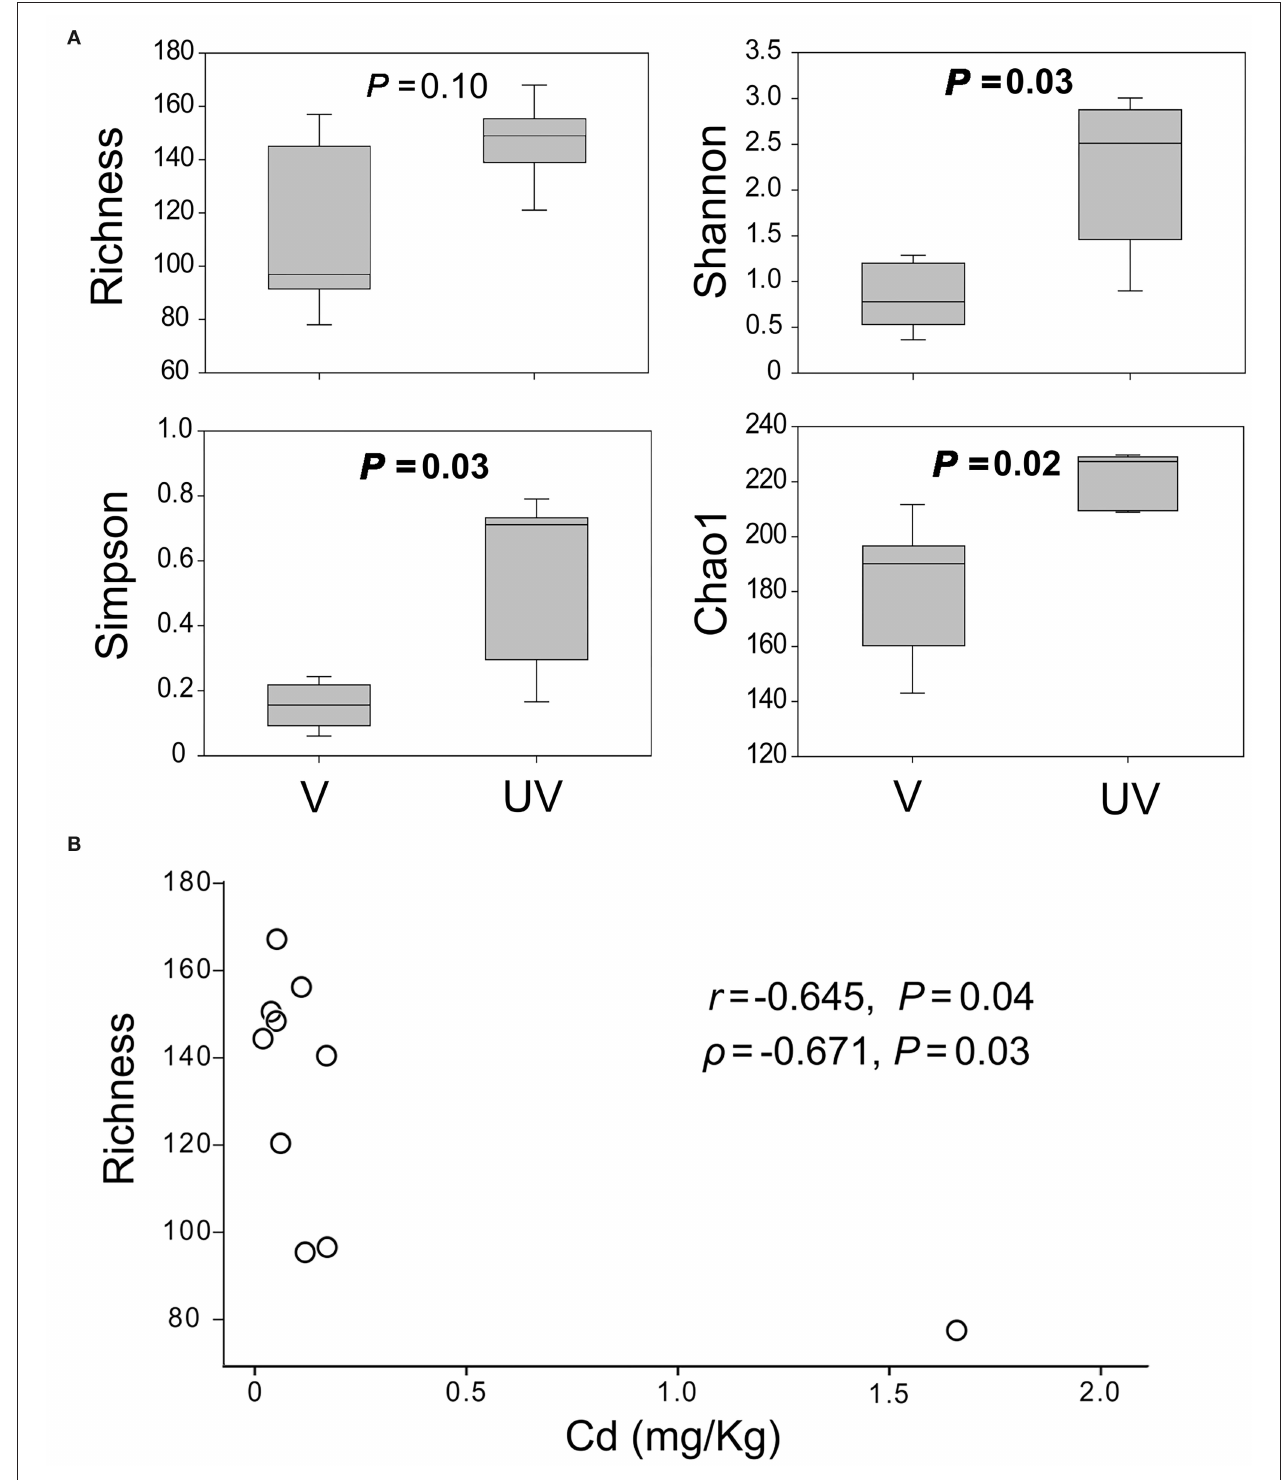
FIGURE 2 | (A) Alpha diversity indices of benthic microeukaryotic OTUs, showing the Shannon, Simpson, and Chao1 estimators of microeukaryotes were significantly higher in the unvegetated than in the seagrass-colonized sites at P < 0.05 according to t -test; (B) a negative correlation between microeukaryotic OTU richness and concentration of